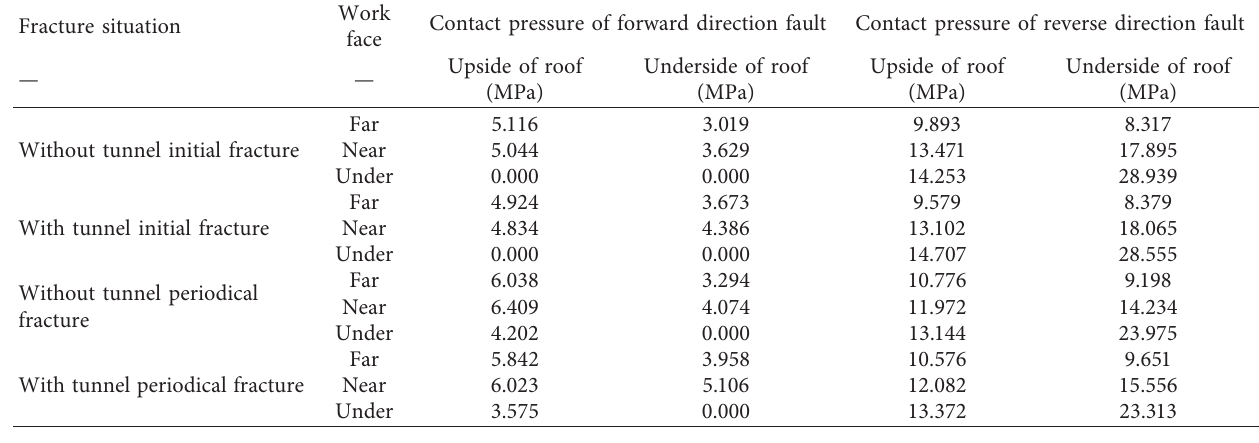
Table 2: The contact pressure of upside and underside of the roof.